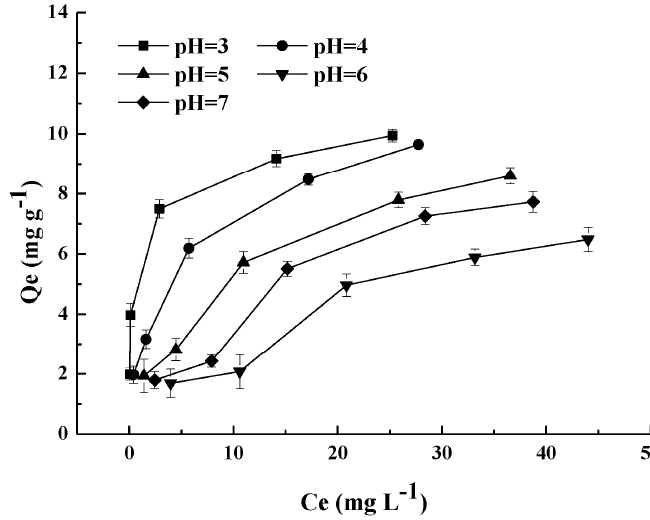
Figure 20. The effect of pH on adsorption by FMCBC 3 [139].